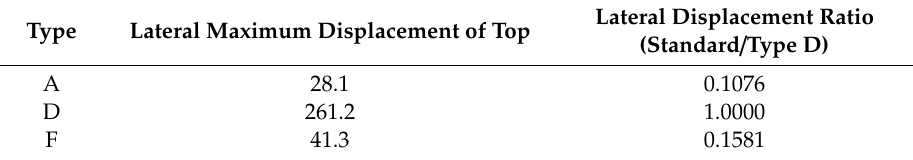
Table 8. Lateral displacement ratio according to installation of back support.